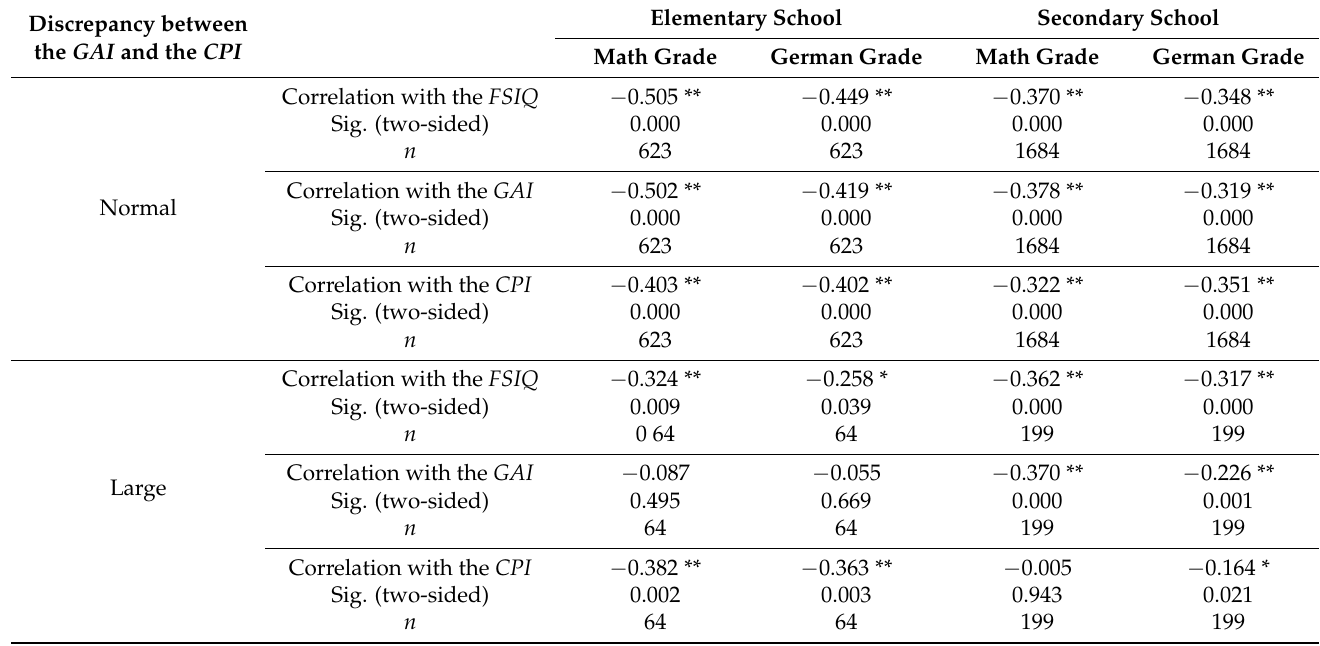
Table 2. Correlations between possible predictors (the FSIQ , the GAI , or the CPI ) and grades in German and mathematics as function of discrepancy between the GAI and the CPI and the type of school. Discrepancy between the GAI and the